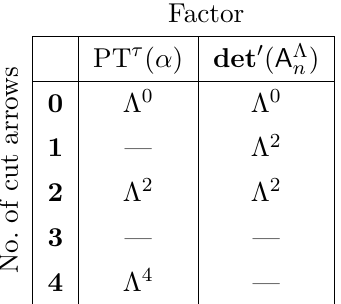
Table 1 . The table displays the dependence of (cid:3) in the integrand factors when expanding around (cid:3) = 0. Some entries are empty, meaning that they are impossible to achieve. E.g. the Parke-Taylor factor only appears when an even number of arrows are cut. This is because the PT factor forms a closed ring. Similarly, the reduced determinant enters with two arrows, so at most two arrows can be cut.